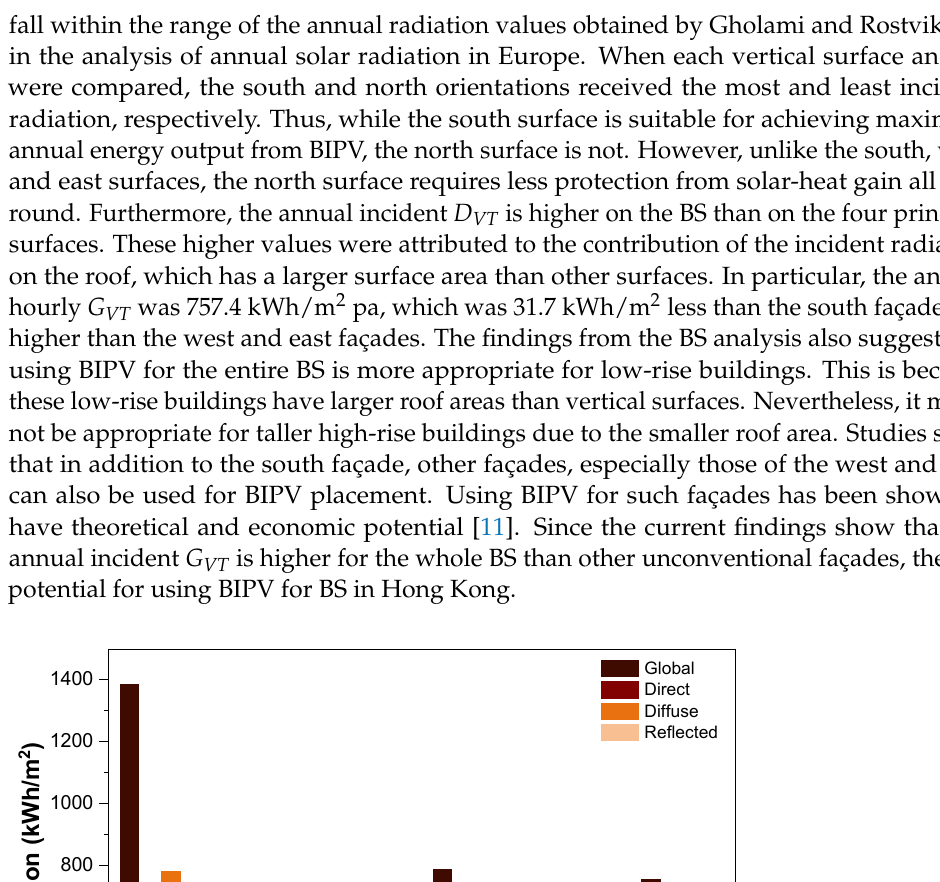
Table 4. Annual incident solar radiation and daylight illuminance on building skins with the con- tribution of each component.